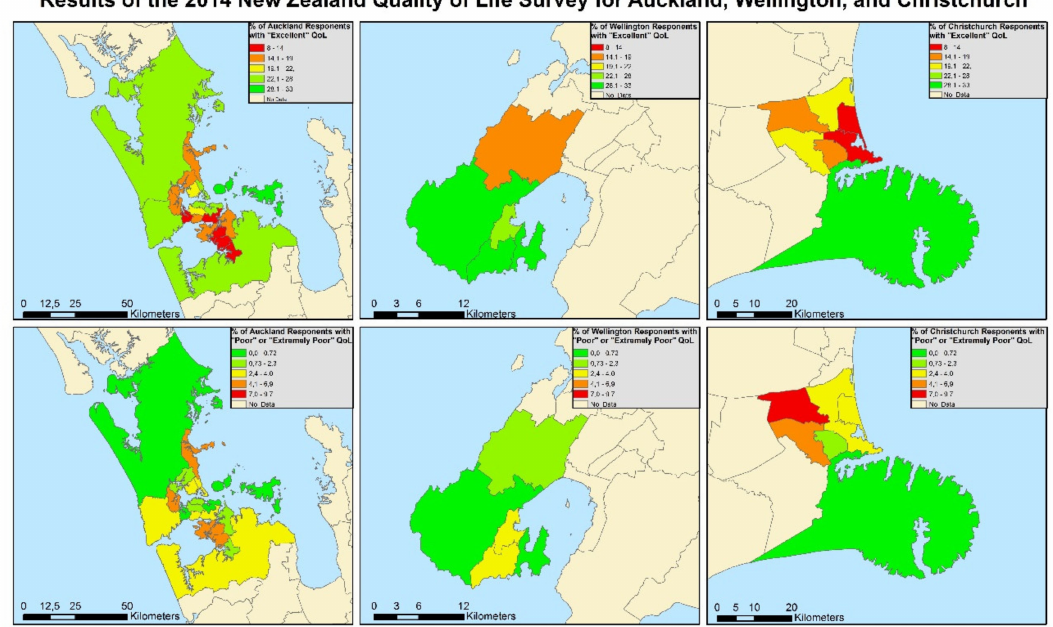
Figure 1. Excellent (top) and poor (bottom) subjective quality of life for Auckland (left), Wellington (center) and Christchurch (right). Source: Authors’ own depiction based on the results of the 2014 NZ Quality of Life